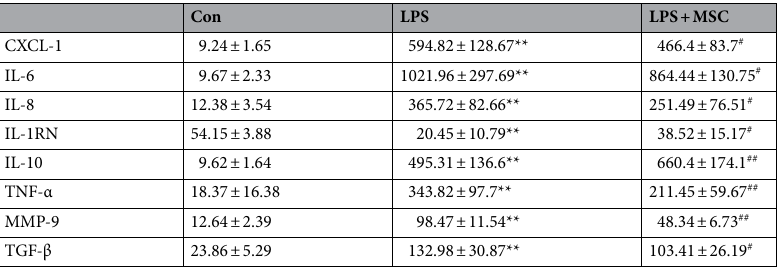
Table 2. Cytokine levels in the BALF (pg/mL) at 6 h after LPS treatment. Our data revealed that LPS increased the levels of CXCL-1, IL-6, IL-8, IL-10, MMP-9, TNF-α, and TGF-β and decreasing the levels of IL-1RN in the BALF. Compared with the LPS group, BM-MSCs administration increased the levels of IL-10 and IL-1RN and decreased the levels of CXCL-1, IL-6, IL-8, MMP-9, TNF-α, and TGF-β in BALF. Values are expressed as the mean ± SD. # P < 0.05 versus the LPS group. ** P < 0.01 versus the Sham group. ## P < 0.01 versus the LPS group.